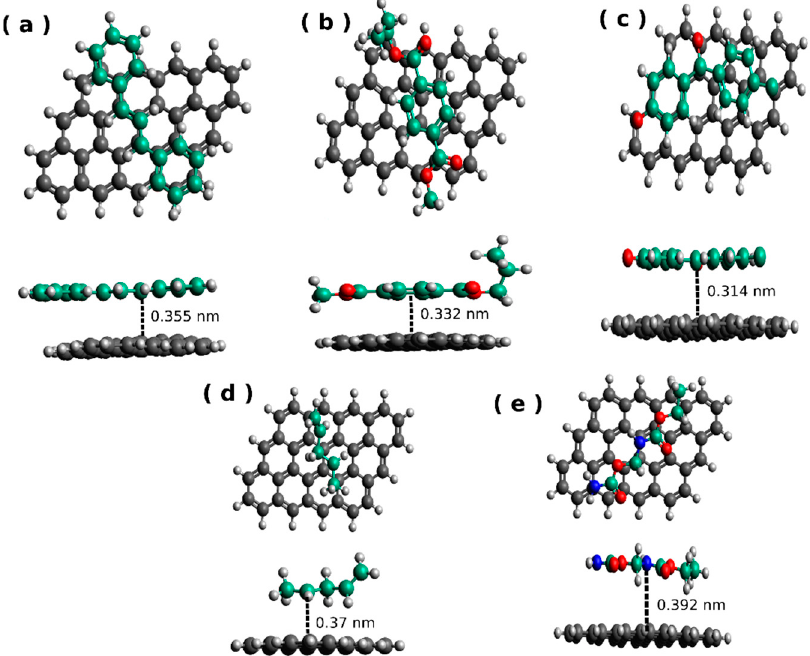
Figure 2. The optimized geometries: ( a ) PS-graphene; ( b ) PET-graphene; ( c ) PEK-graphene; ( d ) PP-graphene; and ( e ) PU-graphene. The carbon of the polymer chain is presented in green with the only purpose of being distinguishable from the graphene cluster.